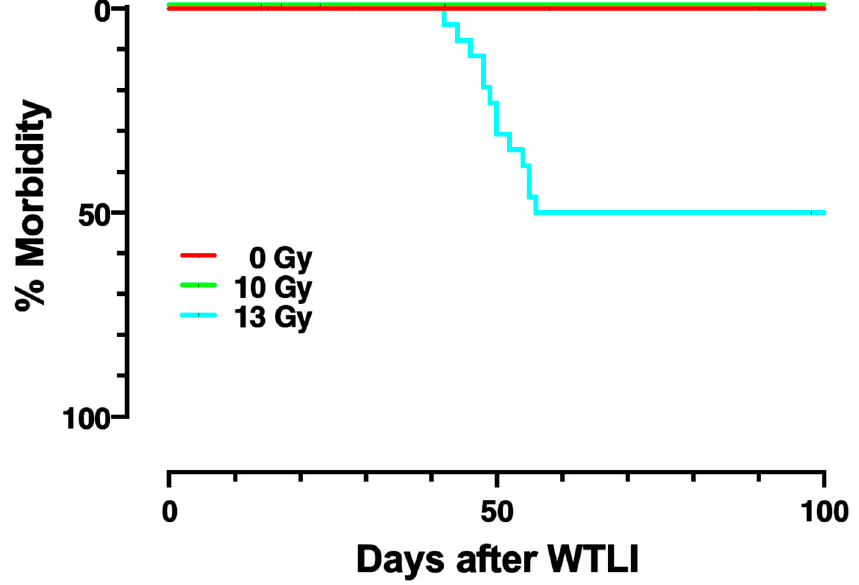
Figure 1. Kaplan–Meier plots for percent morbidity (X-axis) from pneumonitis in control female rats and those given whole thorax lung irradiation (WTLI) and followed for 100 days post-irradiation (X-axis). Three doses of radiation are represented: (1) no irradiation (0 Gy—red line), (2) 10 Gy WTLI (green line) and (3) 13 Gy WTLI (blue line).